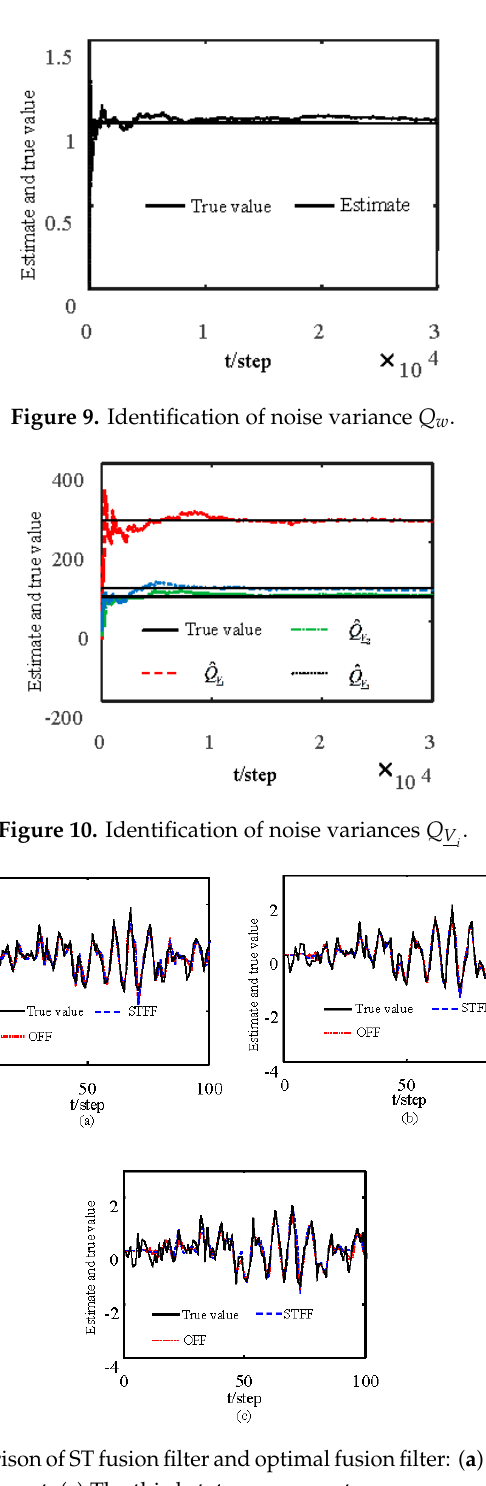
Figure 8. Local estimates of unknown parameter